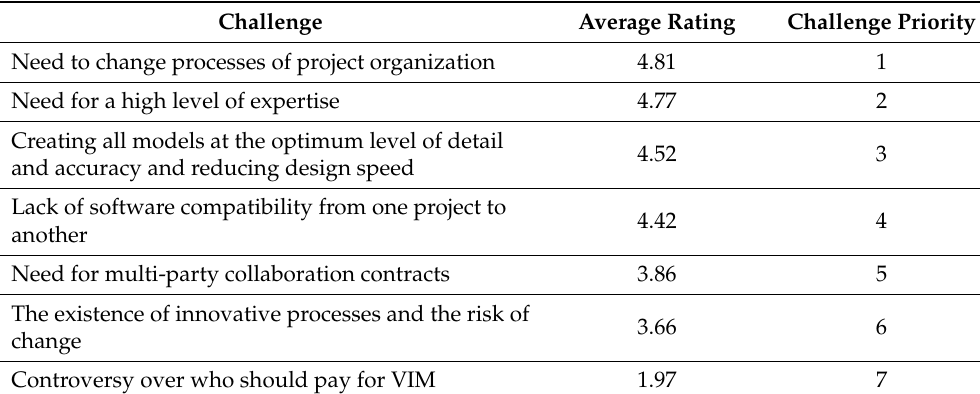
Table 11. Average rating of challenges of VIM application among confirmed